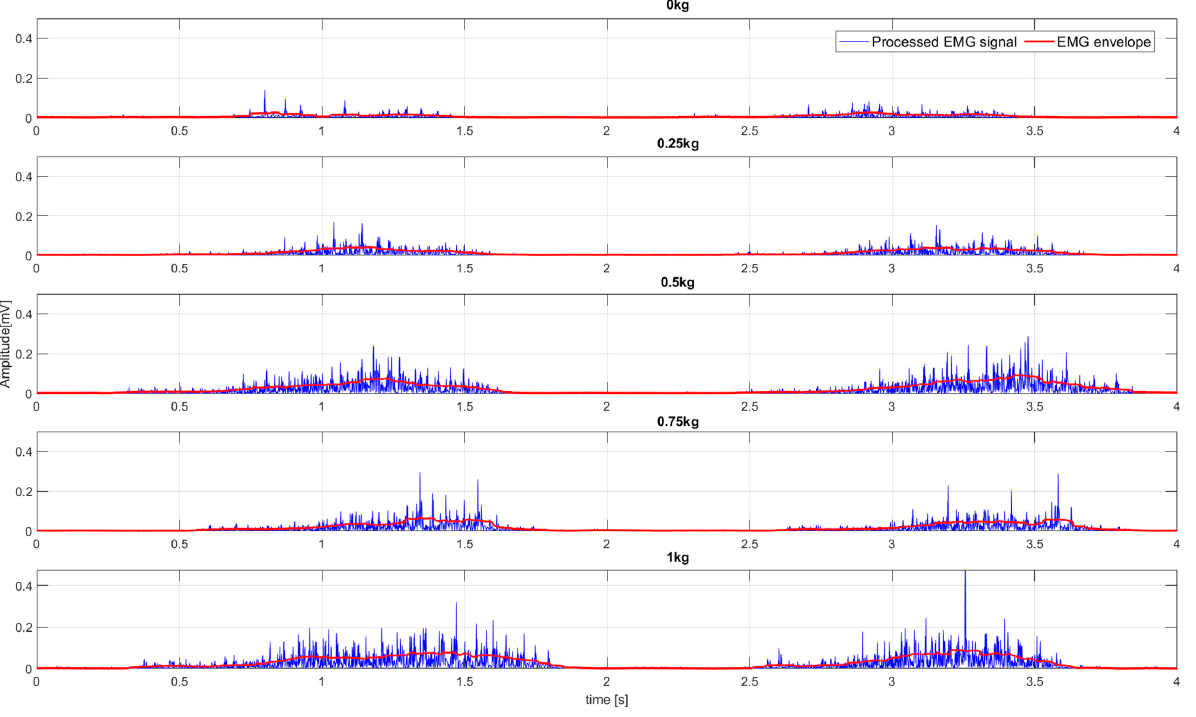
Figure A2. Muscle activation estimation: Processed EMG signal (blue line) and EMG envelope (red line) in task E2.